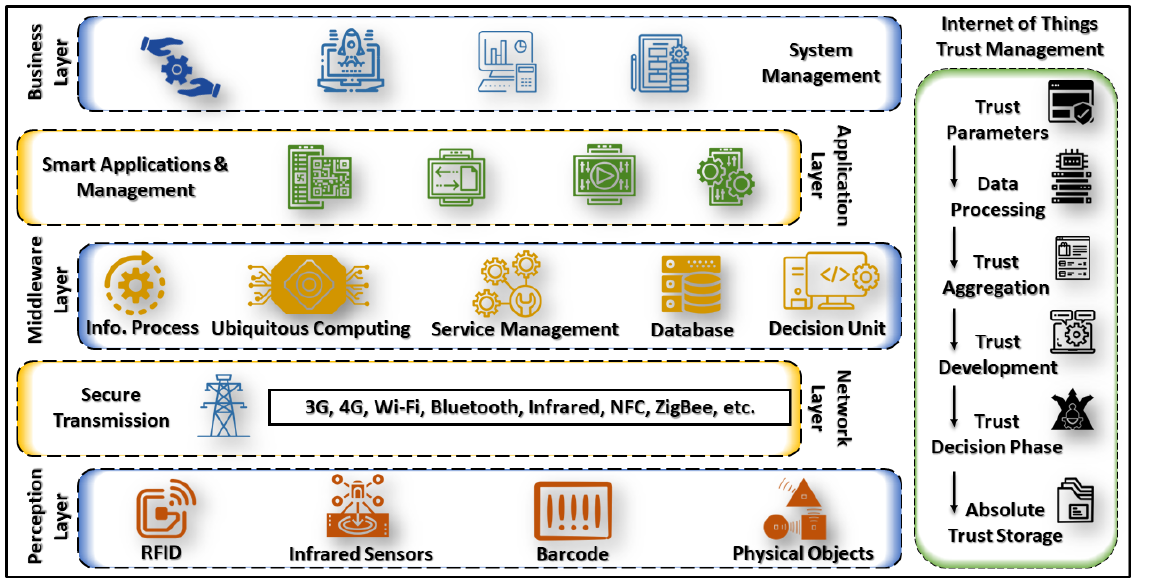
Figure 1. IoT architecture with the integration of trust